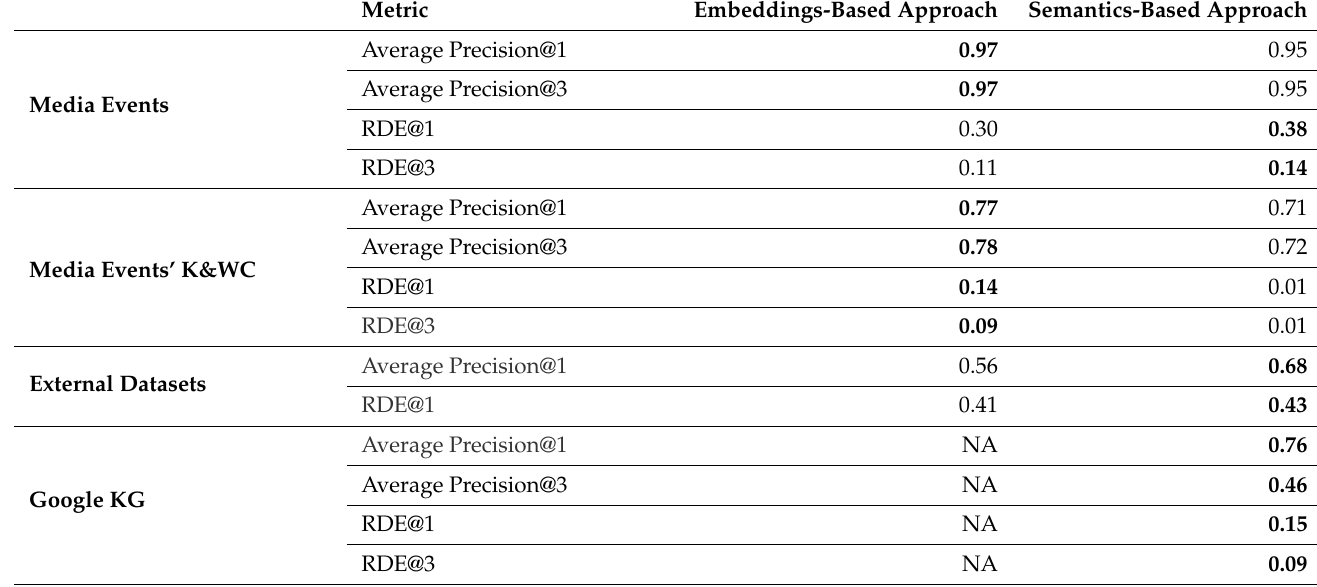
Table 2. Results we obtained by analyzing the forecast explanations created for 56 products over three months. The best results are shown in bold. Media events , Media events’ keywords , external datasets and Google KG correspond to contextual information displayed for each forecast explanation. NA is used for entries regarding the results concerning the Google KG for the embeddings-based approach, given that the research we compare against did not provide such